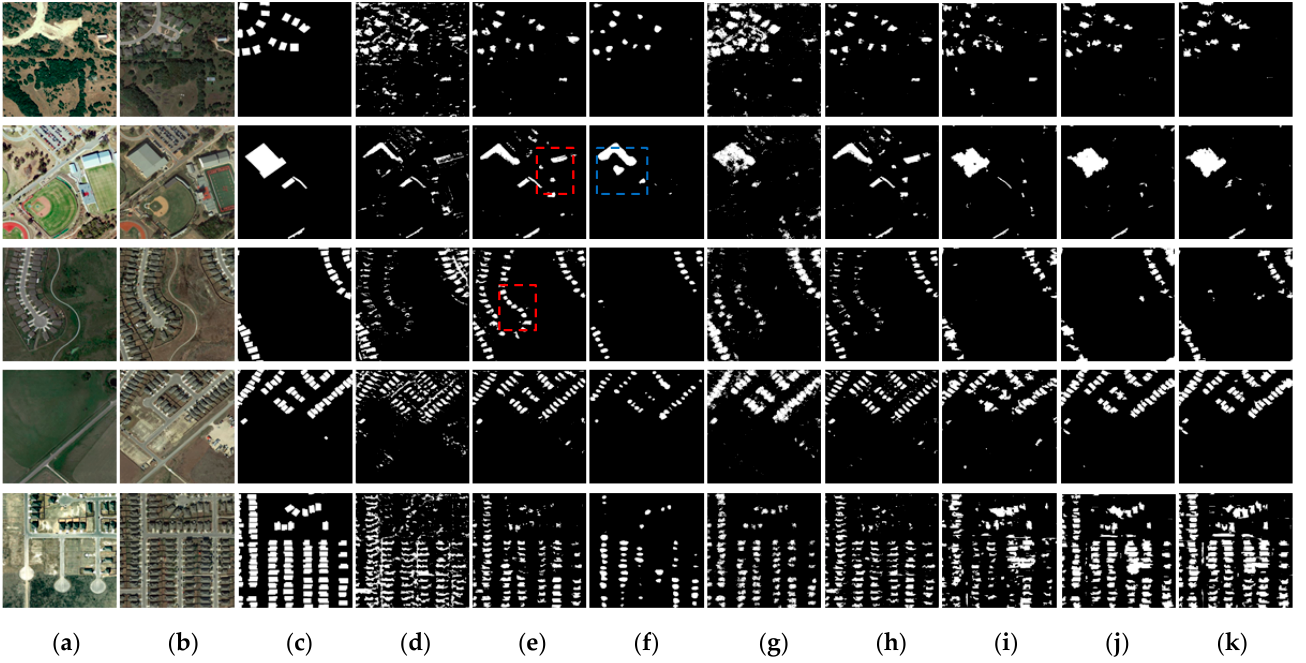
Figure 12. Some typical CD maps by different methods on the LEVIR-CD data set. ( a ) Image T1. ( b ) Images T2. ( c ) Reference change map. ( d ) FC-Siam-con. ( e ) FC-Siam-diff. ( f ) Siam-NestedUNet. ( g ) DSFIN. ( h ) DSAMNet. ( i ) GCNCD. ( j ) MSGCN. ( k ) DNHGNN.